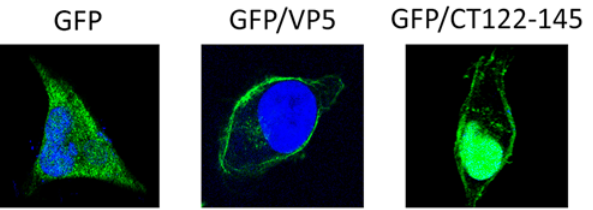
Fig 2. GFP PM targeting mediated by the 24 VP5 C-terminal residues. HeLa cells were transfected with plasmids encoding GFP (GFP), GFP fused to the VP5 ORF (VP5/GFP) or GFP fused to the 24 VP5 C- terminal residues (GFP/CT122-145). At 12 h post-transfection cultures were fixed and processed for IF using a mouse anti-GFP mAb followed by incubation with goat anti-mouse coupled to Alexa-488. Nuclei were stained with DAPI. Cells were visualized by CLSM. Fluorescence signals were recorded separately by using appropriate filters. Presented images correspond to confocal sections showing the overlay of the two fluorescence signals, and are characteristic examples of the GFP-specific immunofluorescence observed in cells transfected with the different plasmids.